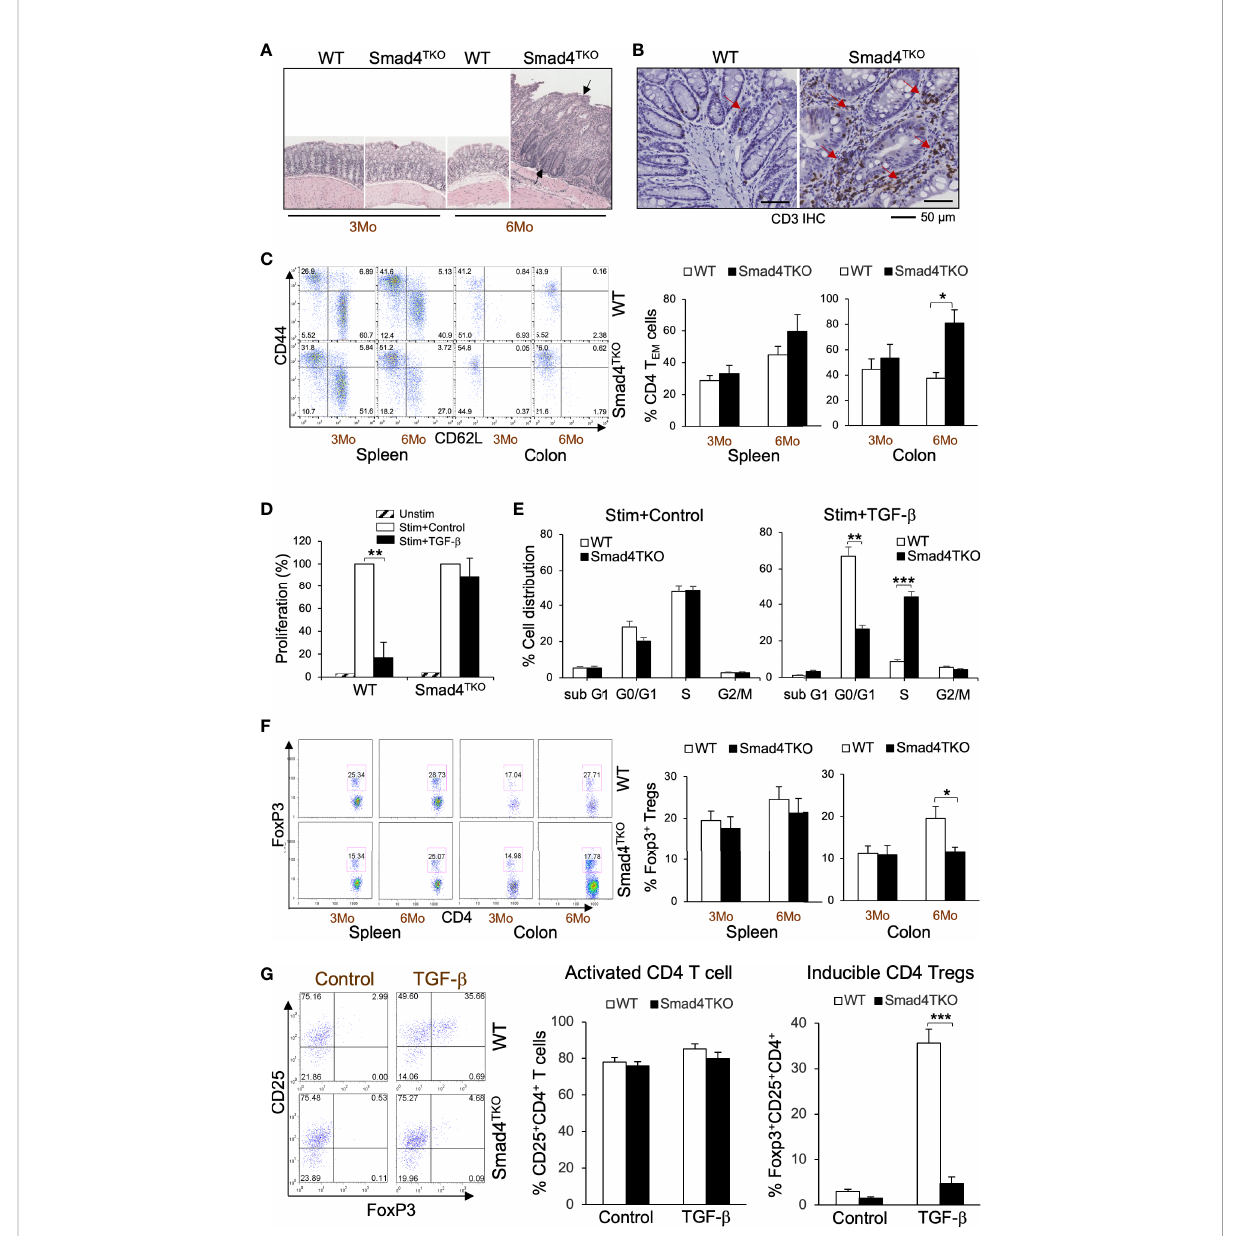
FIGURE 1 Smad4 deletion in T cell leads in fl ammation-associated colon cancer with an increase in effector memory T cell population and a decrease in natural regulatory T cell (nTreg) population. (A) Hematoxylin and eosin (H&E) staining of the colon of wild type and Smad4 TKO mice at 3 and 6 months of age. (B) Immunohistochemistry (IHC) staining for CD3 in colons of each genotype at 6 months of age. Scale = 50 m m. (C) Analysis of effector memory markers (CD44 High CD62L Low ) in CD4 + T cell compartment of spleen and colon lamina propria of WT and Smad4 TKO at 3 and 6 months of age (n=3-5). (D) Analysis of CD4 T cell proliferation suppressed by TGF- b . Cells from Spleen per genotype at 2 months of age (n=3) were collected and incubated with anti-CD3/CD28 for 72 hours with or without TGF- b (2 ng/ml) and the proliferation of CD4 T cells was measured by H 3 thymidine incorporation. (E) Cell cycle analysis of CD4 T cells per genotype (n=3). CD4 T cells from panel D were incorporated with BrdU for the last 16 hrs incubation, harvested, intracellularly stained with anti-BrdU and 7AAD. (F) Analysis of natural regulatory T (nTreg) cell population in CD4 + T cell compartment from spleen and colon lamina propria of WT and Smad4 TKO at 3 and 6 months of age (n=3-5). Splenocytes and colon lamina propria cells per genotype at 3 and 6 months of age were collected, stained on cell surface with antibody for CD4 and intracellularly with Foxp3 antibody, and analyzed on CD4 + T cells by FACS. (G) Analysis of TGF- b -induced Treg (iTgreg) population in CD4 + T cell compartment of each genotype. Cells from Spleen per genotype at 2 months of age (n=4) were collected and incubated with anti-CD3/CD28 for 72 hours with or without TGF- b (2 ng/ml) and intracellularly stained with Foxp3 antibody. Error bars indicate S.E.; * p < 0.05, ** p < 0.01, *** p <